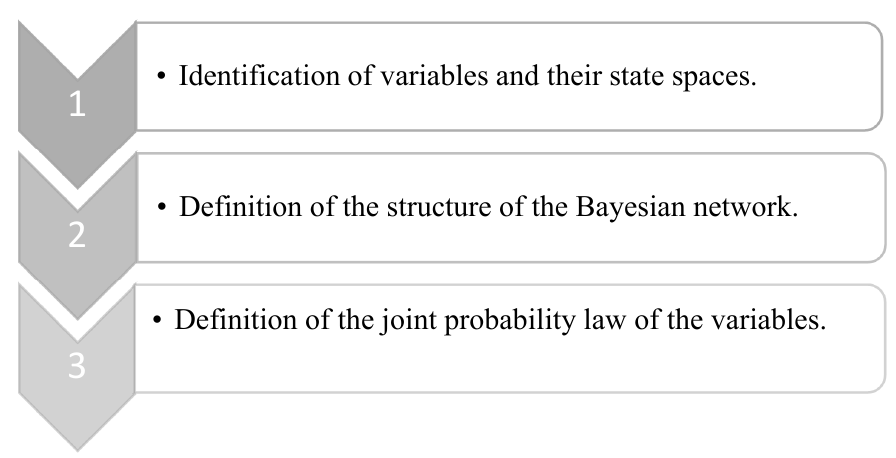
Figure 3. The steps of building a Bayesian network for STPP.